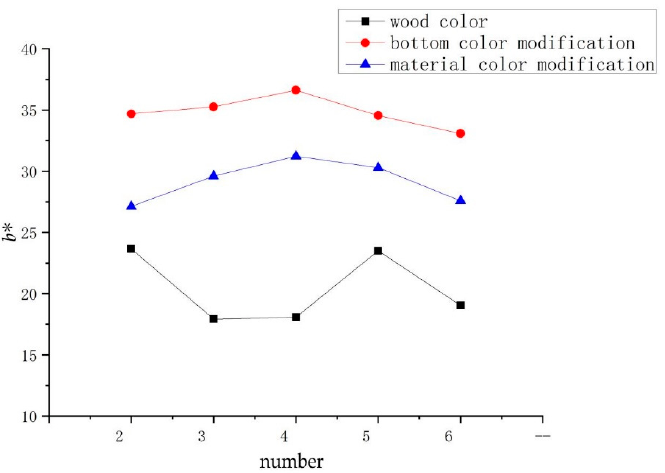
Figure 7. The effect of different surface disposition to b *.